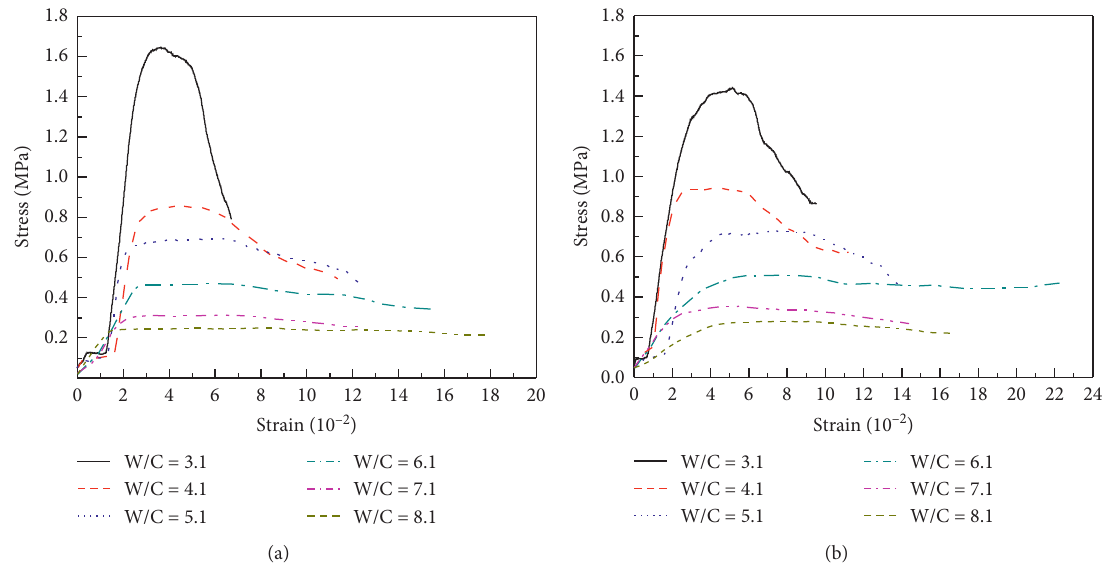
Figure 10: Stress-strain curves of the HWBM samples with different W / C : (a) untreated samples and (b) modified